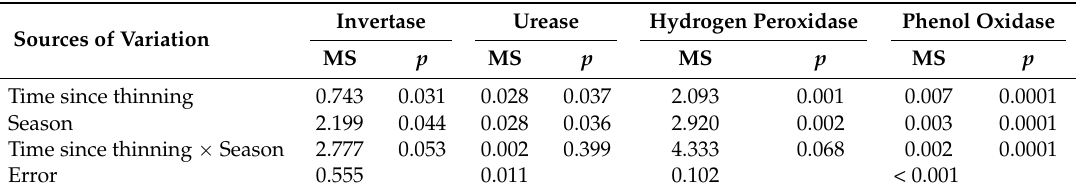
Table 2. p -values from the ANOVA for the effect of time since thinning, seasons (spring, summer and autumn), and their interaction on soil enzyme activities.